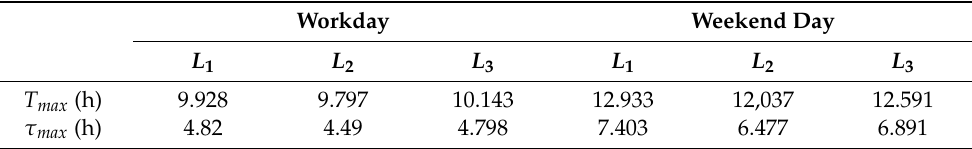
Table 8. The duration of maximum power usage T max and the duration of maximum losses τ max ( t = 24